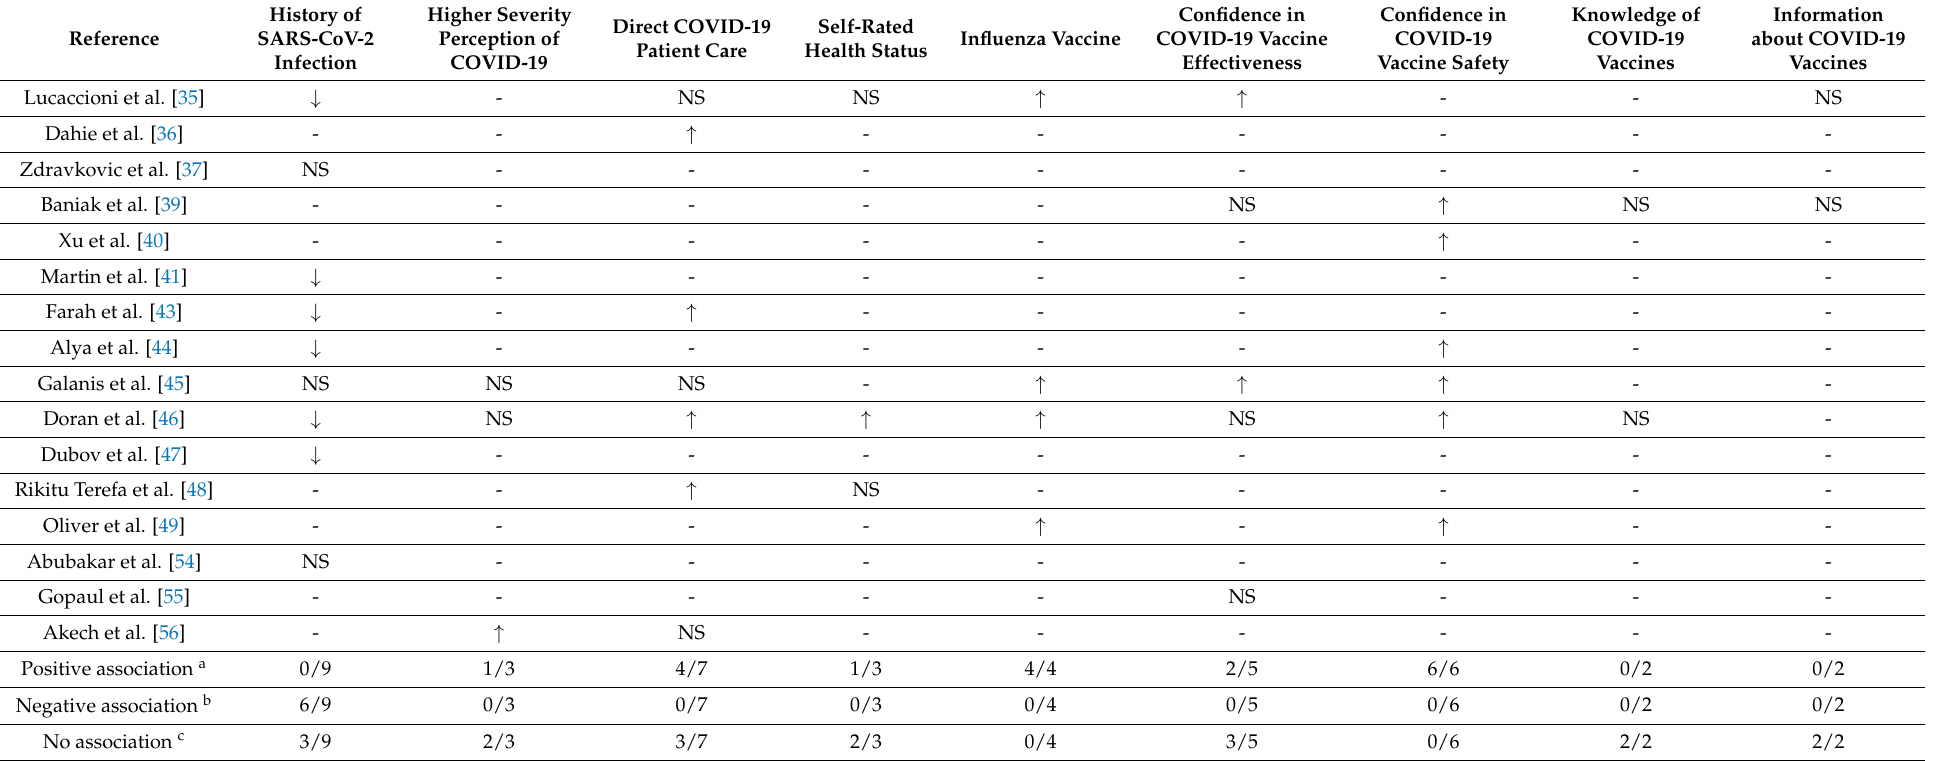
Table 2. Predictors of COVID-19 vaccine uptake among healthcare